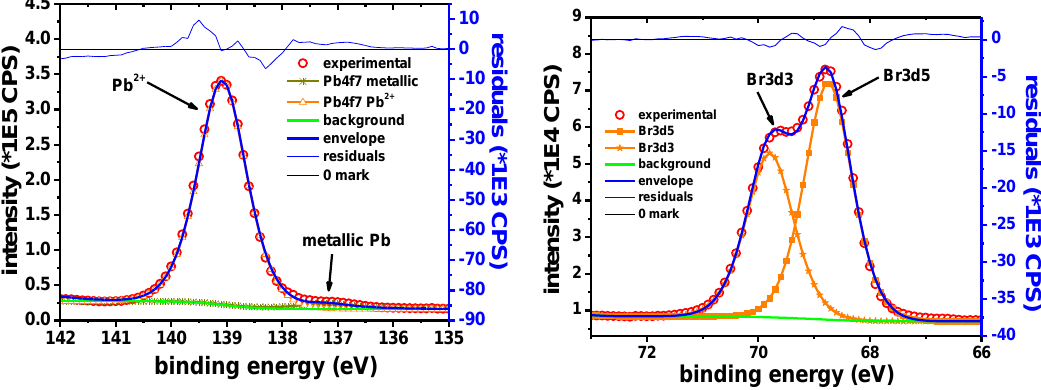
Figure 15. Pb 4f 7 / 2 narrow scan ( left ); and Br 3d narrow scan ( right ). Figure 15. Pb 4f 7/2 narrow scan ( left ); and Br 3d narrow scan ( right ).